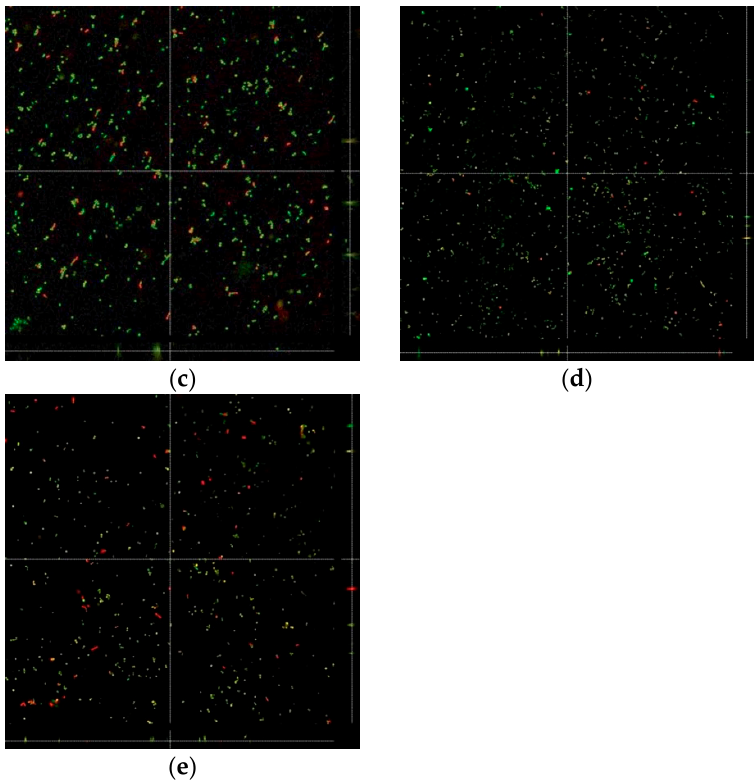
Figure 9. Biofilm thickness of Streptococcus mutans. Green fluorescence indicates viable cells; red fluorescence indicates dead cells. The thickness of the biofilm in the photograph can be determined from the right and bottom lines. ( a ) Control (no treatment), ( b ) P0 group (immediately after treatment), ( c ) P1 group (24 h after treatment), ( d ) P2 group (48 h after treatment), ( e ) P3 group (72 h after treatment).